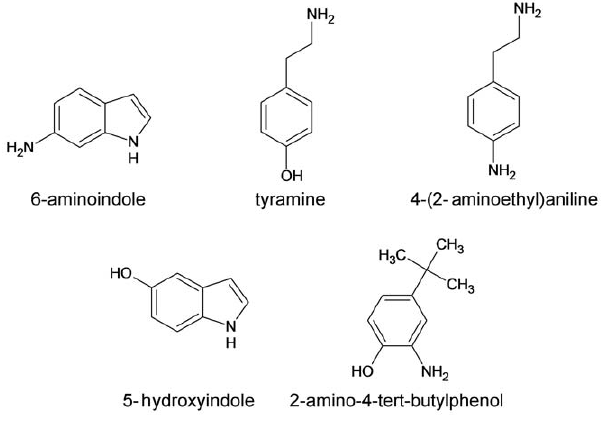
Figure 2. Chemical structures of the five DOP analogs chosen for the insilico/invitro analysis.